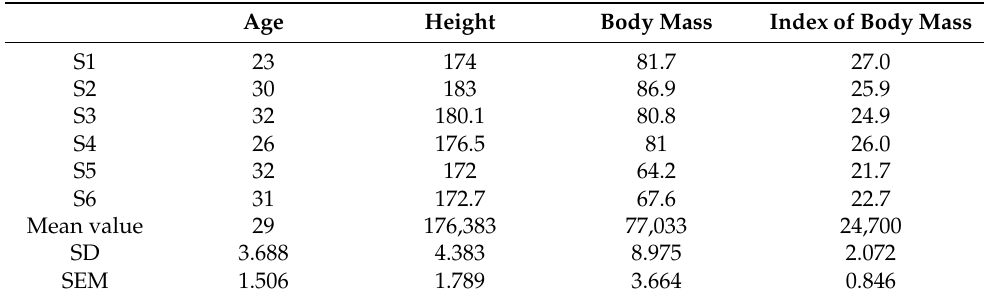
Table 1. Subject’s body